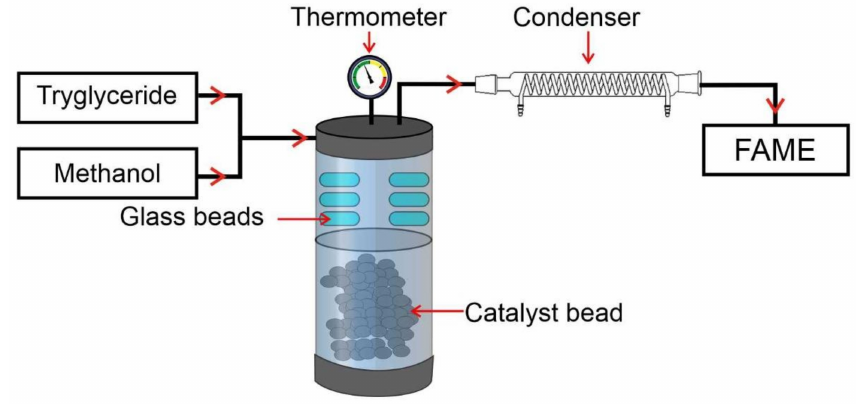
Figure 4. Schematic of trickle-bed reactor.